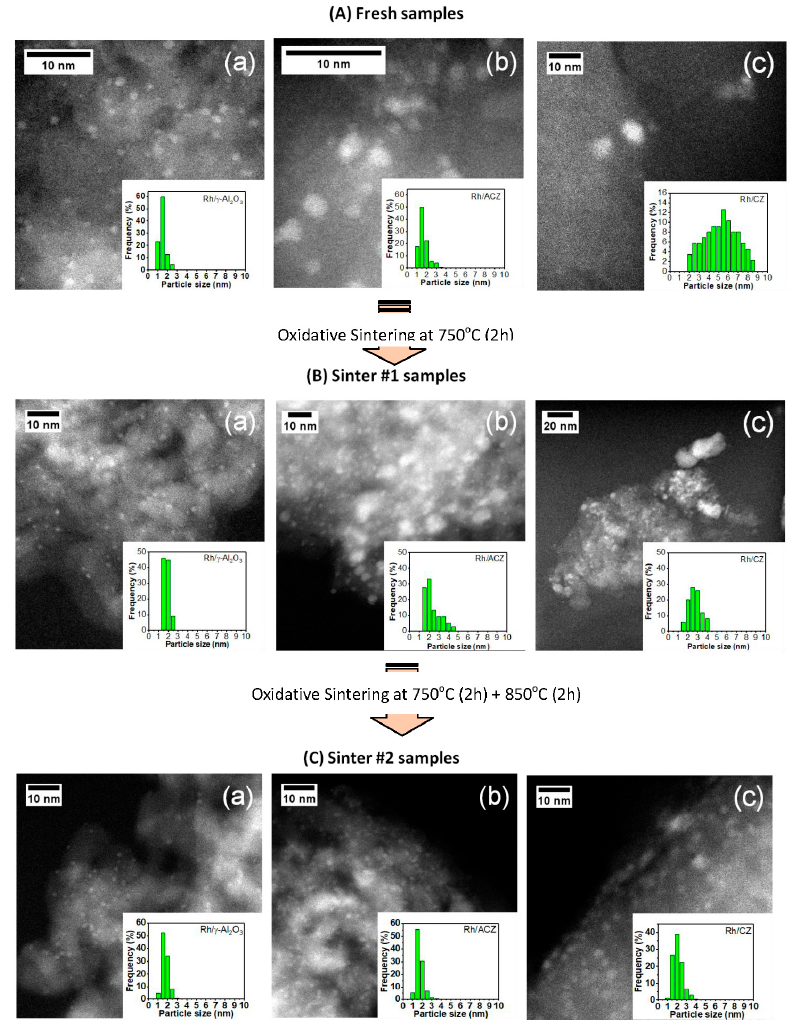
Figure 4. High-resolution transmission electron microscopy (HRTEM) images and particle size distributions of ( A ) fresh, ( B ) Sinter #1 and ( C ) Sinter #2 ( a ) Rh / γ -Al 2 O 3 , ( b ) Rh / ACZ and ( c ) Rh / CZ catalysts.